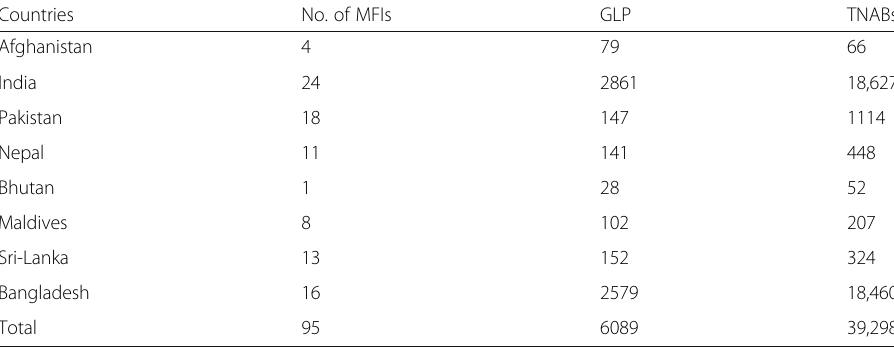
Table 1 Sample Description of South Asian MFIs Countries No. of MFIs GLP